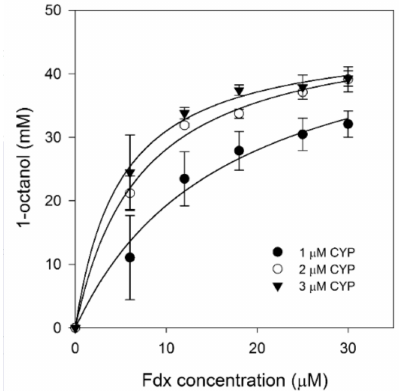
Figure 4. Effect of CYP153A6 and ferredoxin (Fdx) concentration on 1-octanol yields. Reaction conditions: 1 mL aqueous reaction mixture containing 1–3 µ M CYP153A6, 1 µ M FdR, 0–30 µ M Fdx,